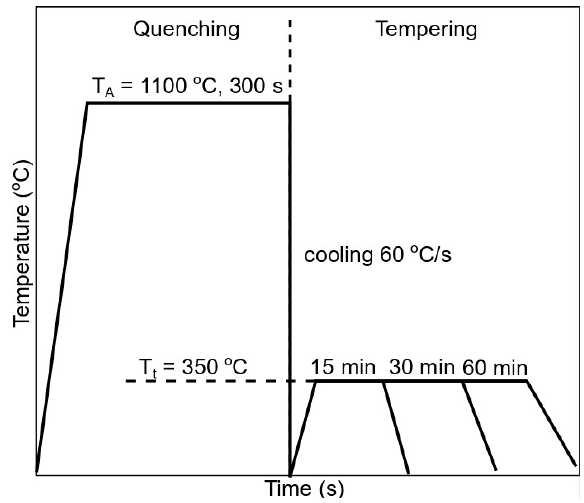
Figure 1. A schematic of the heat treatment.